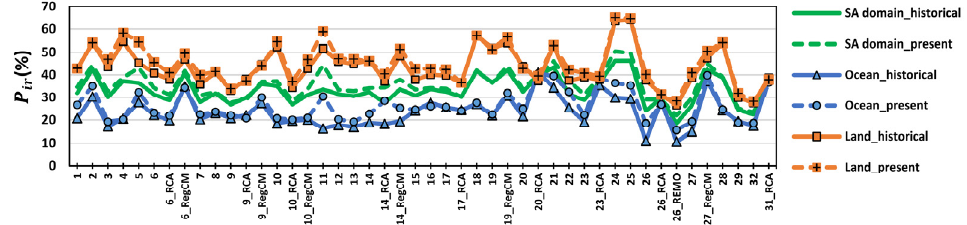
Figure 4. As in Figure 2, but this summarizes the climate model’s skill in capturing annual cycle pattern; percentage of statistically insignificant positive correlation coefficient ( P ir , %) on y -axis and Model ID on x-axis.